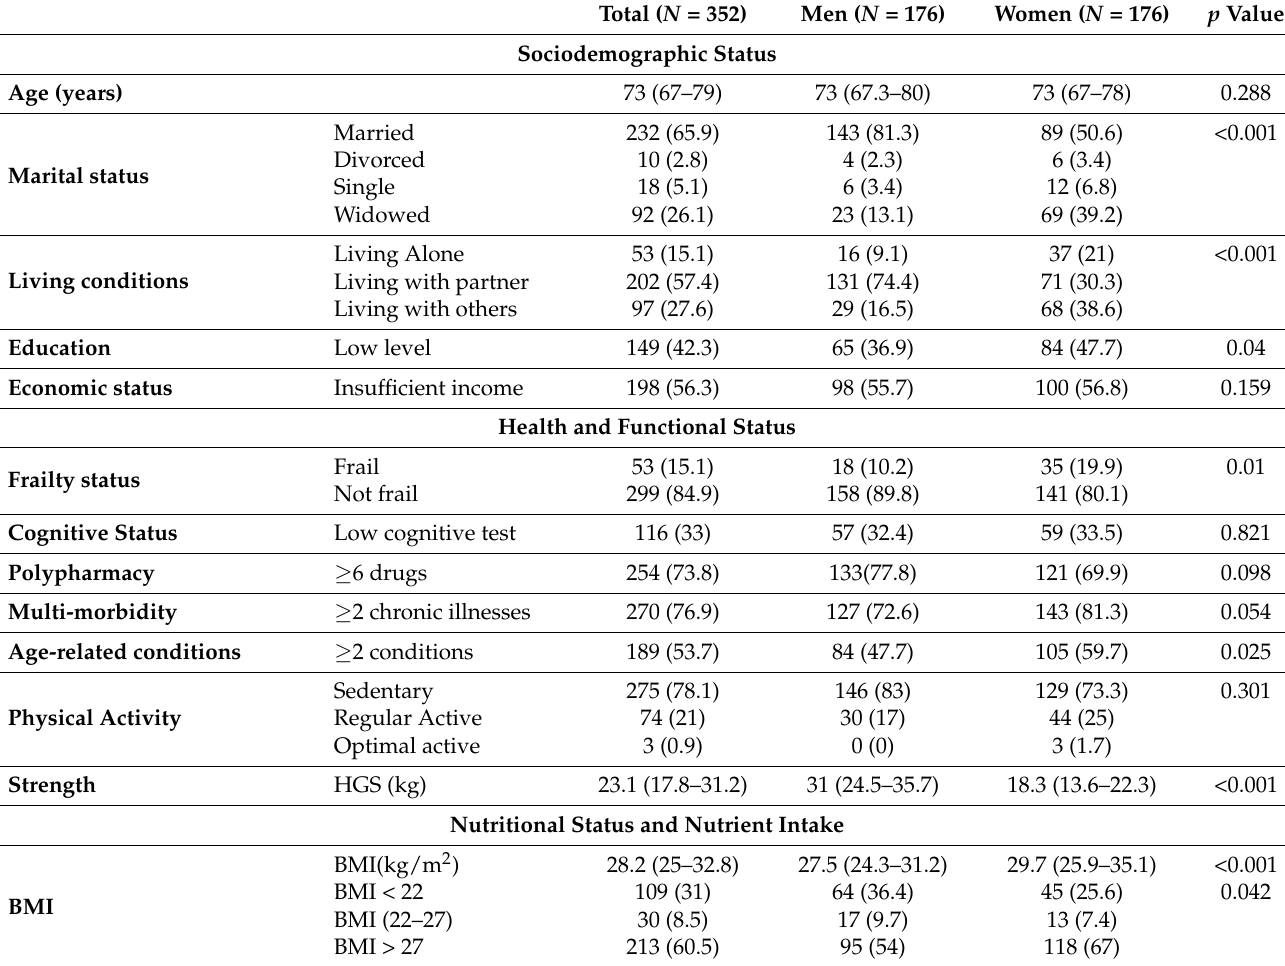
Table 1. Sociodemographic and clinical characteristics of the total sample, and stratified by gender ( N =